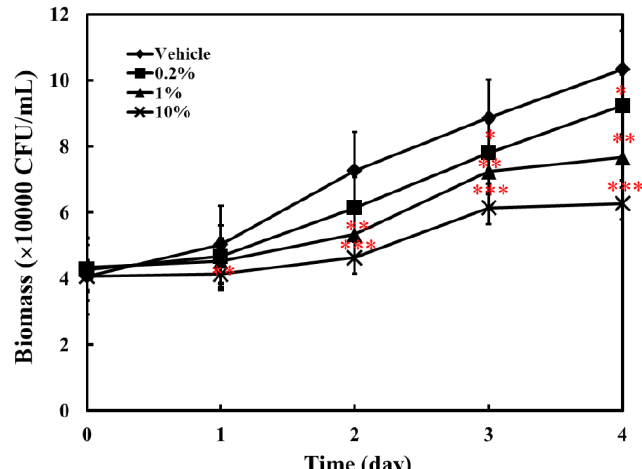
Figure 1. Total bacterial plate count of tank water during 4-day cultivation. Thirty fish were used in each group and placed in the same aquarium with one fifth of tank water changed every day during the feeding experiment period. Significant difference compared with the vehicle group was denoted as * p < 0.05, ** p < 0.01, and *** p < 0.001.